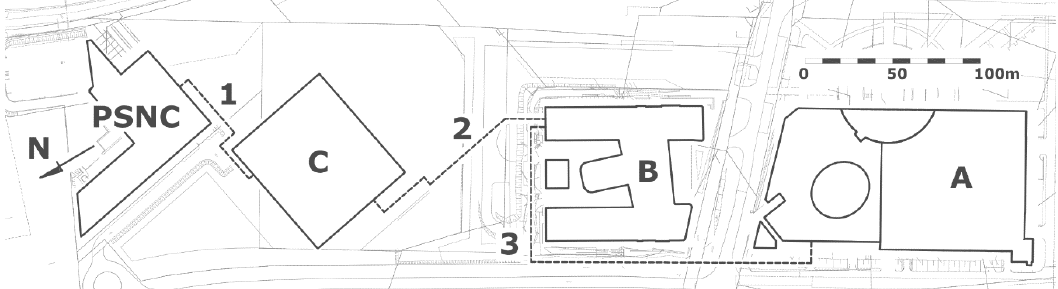
Figure 4. Loop connection schema for the considered buildings.